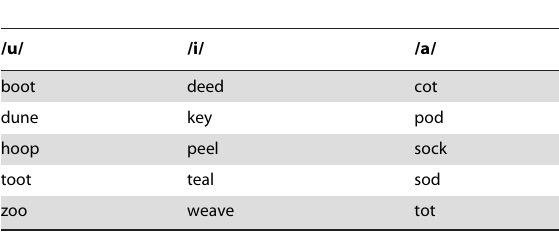
Table 1. Stimuli used in the